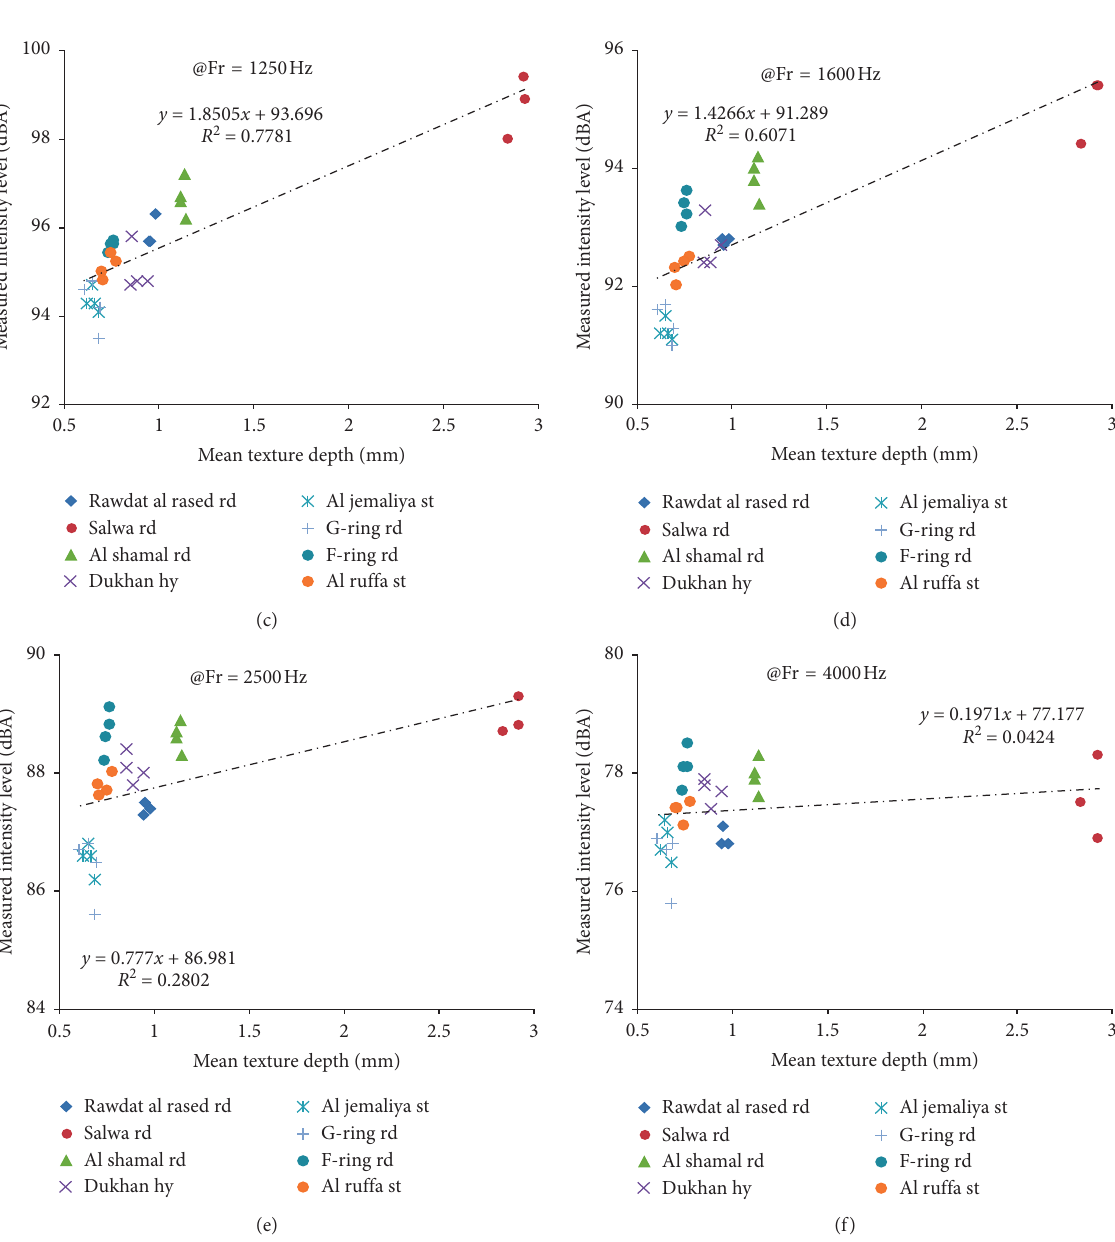
Figure 9: Correlation between mean texture depth (MTD) and OBSI level at the 1/3rd frequency